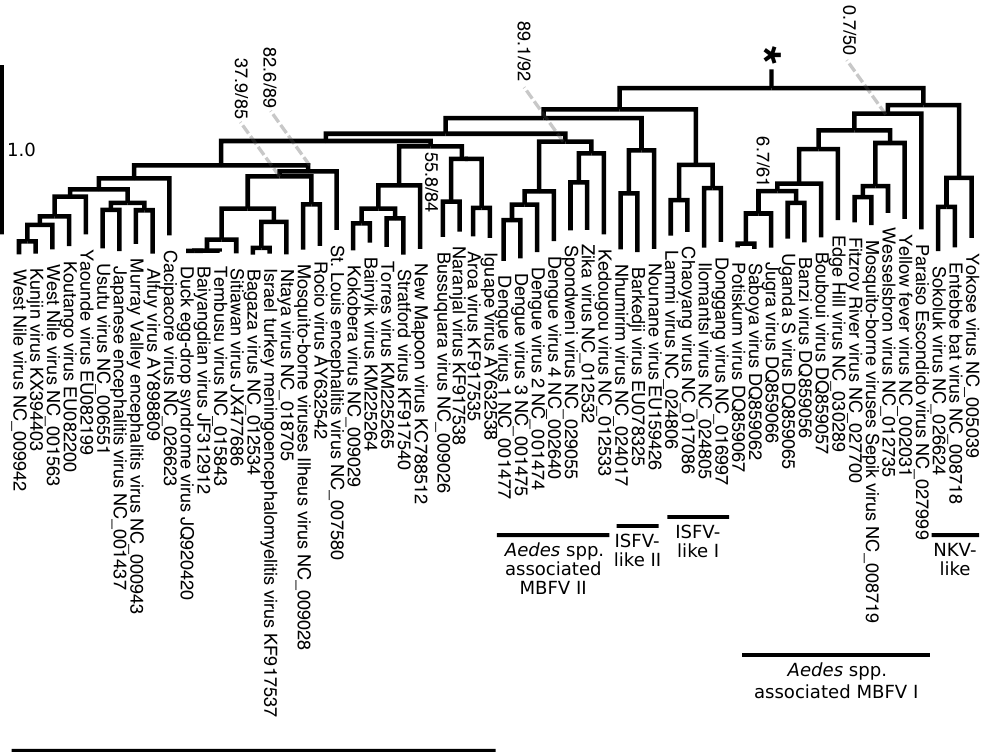
Figure 9. Continuation (from *) of the working phylogenetic hypothesis of Flaviviridae (see tree No. 0, Table 1, Figure 8). Branch lengths represent an estimation of average the number of nucleotide substitutions per site. Node labels indicate SH-aLRT support/ultrafast bootstrap (only shown if one of the values is below 90% too improve visualization). This image shows a group within flaviviruses which is sister to (NKV Specific lineage + (Seabird Tick-borne + Mammalian Tick-borne)). ∆ = The Ecuador Paraiso Escondido virus (EPEV) was isolated from sand flies ( Psathyromyia abonnenci ). The EPEV was the first sand fly-borne flavivirus identified in the New World. See Figure S2 (Supplementary Materials) for a full version of this